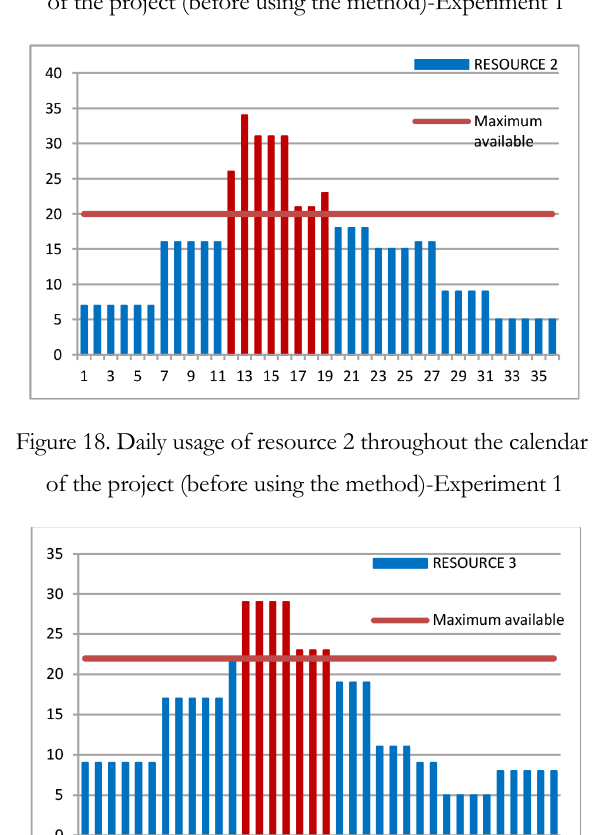
Figure 16. Daily usage of resource 1 throughout the calendar of the project (before using the method)-Experiment 1